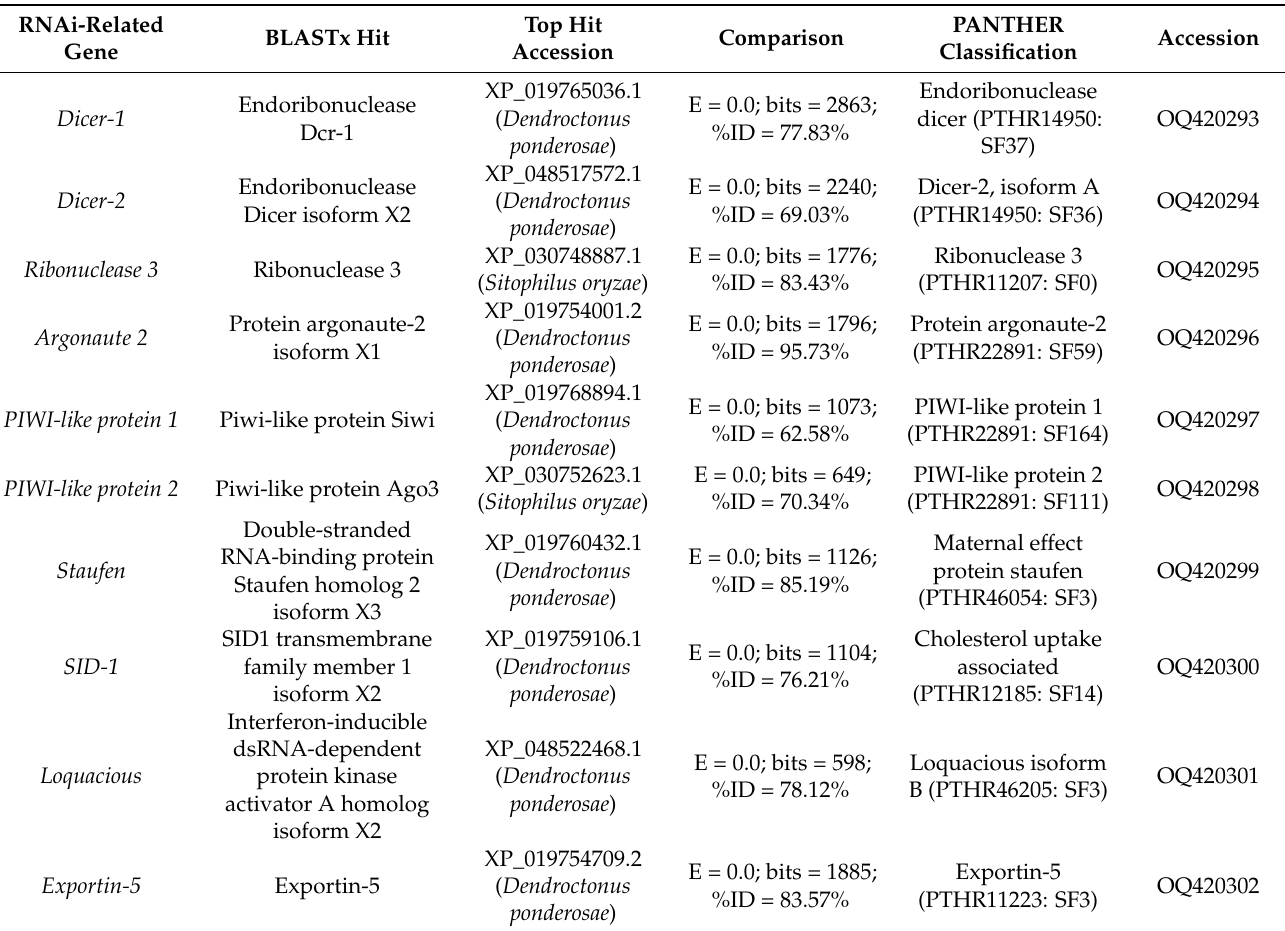
Table 3. Overview of putative RNAi machinery sequences and their similarity (E-value, bit score, and percent identity) to the top hit sequence when used as query for a BLASTx search using NCBIs nr database and their PANTHER classification identified using InterProScan.